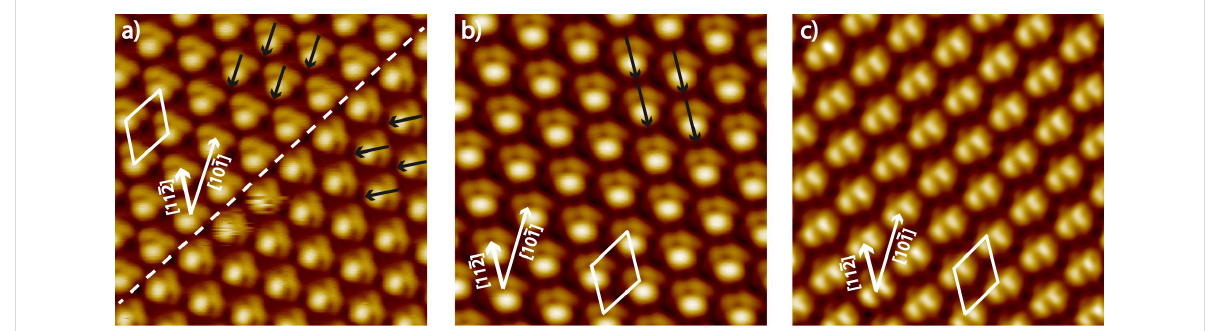
Figure 5: (a) High resolution STM image (7 × 7 nm 2 ) of two u-R30° domains of C 60 adsorbed with the 5:6 C–C bond on Au(111) ( U bias = 0.46 V, I T = 1.0 nA, sample B), which are rotated by 60° to each other. The arrows indicate the orientation of the molecules. (b) STM image (6.25 × 6.25 nm 2 ) of a second u-R30° structure ( U bias = 0.33 V, I T = 0.08 nA, sample A2), which is formed by a 30° rotation of the C 60 with respect to the C 60 in Figure 5a. c) (6.8 × 6.8 nm 2 ) STM image of a third u-R30° structure formed by C 60 adsorbed with the 6:6 C–C bond and slightly tilted ( U bias = 0.80 V,